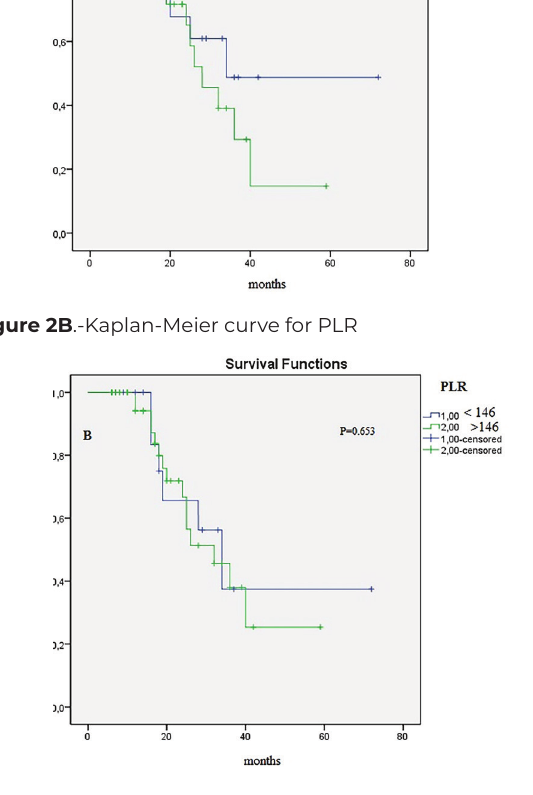
Figure 2C -Kaplan-Meier curve for